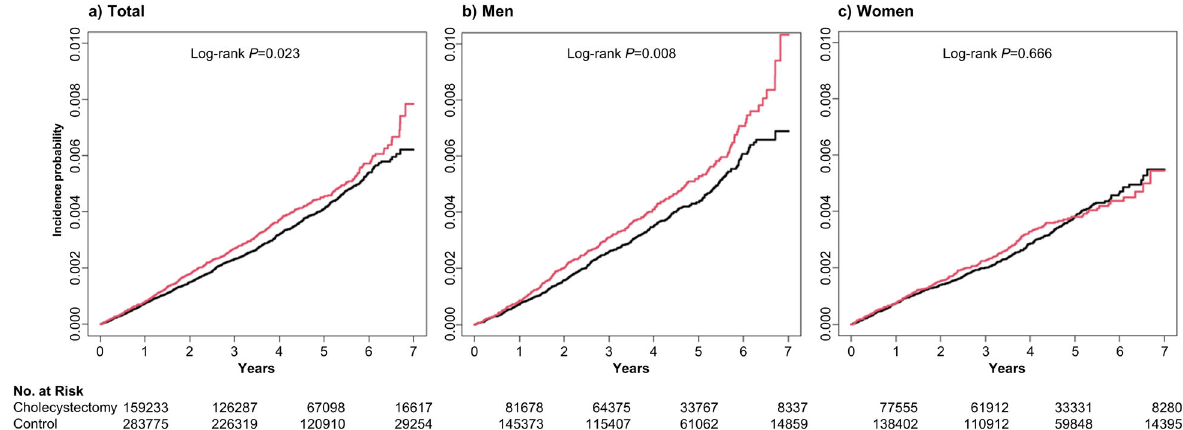
Fig. 2 Kaplan – Meier estimates for the probability of incident Parkinson ’ s disease up to 7 years according to cholecystectomy. a Total population; b Male population; c Female